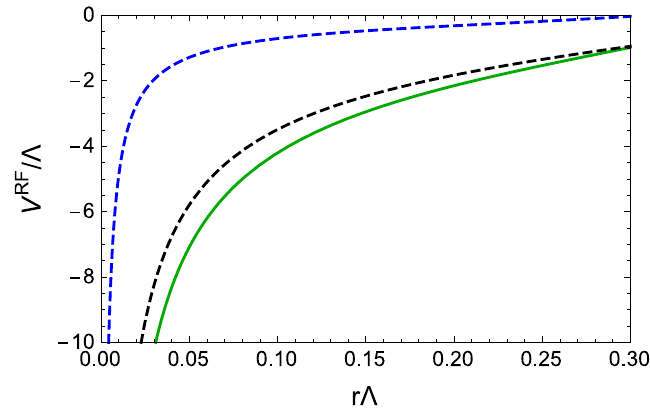
Figure 14 . Renormalon-free prediction for the static QCD potential V RF = (cid:3) function (cid:3) r . Contributions from V RF MS shown